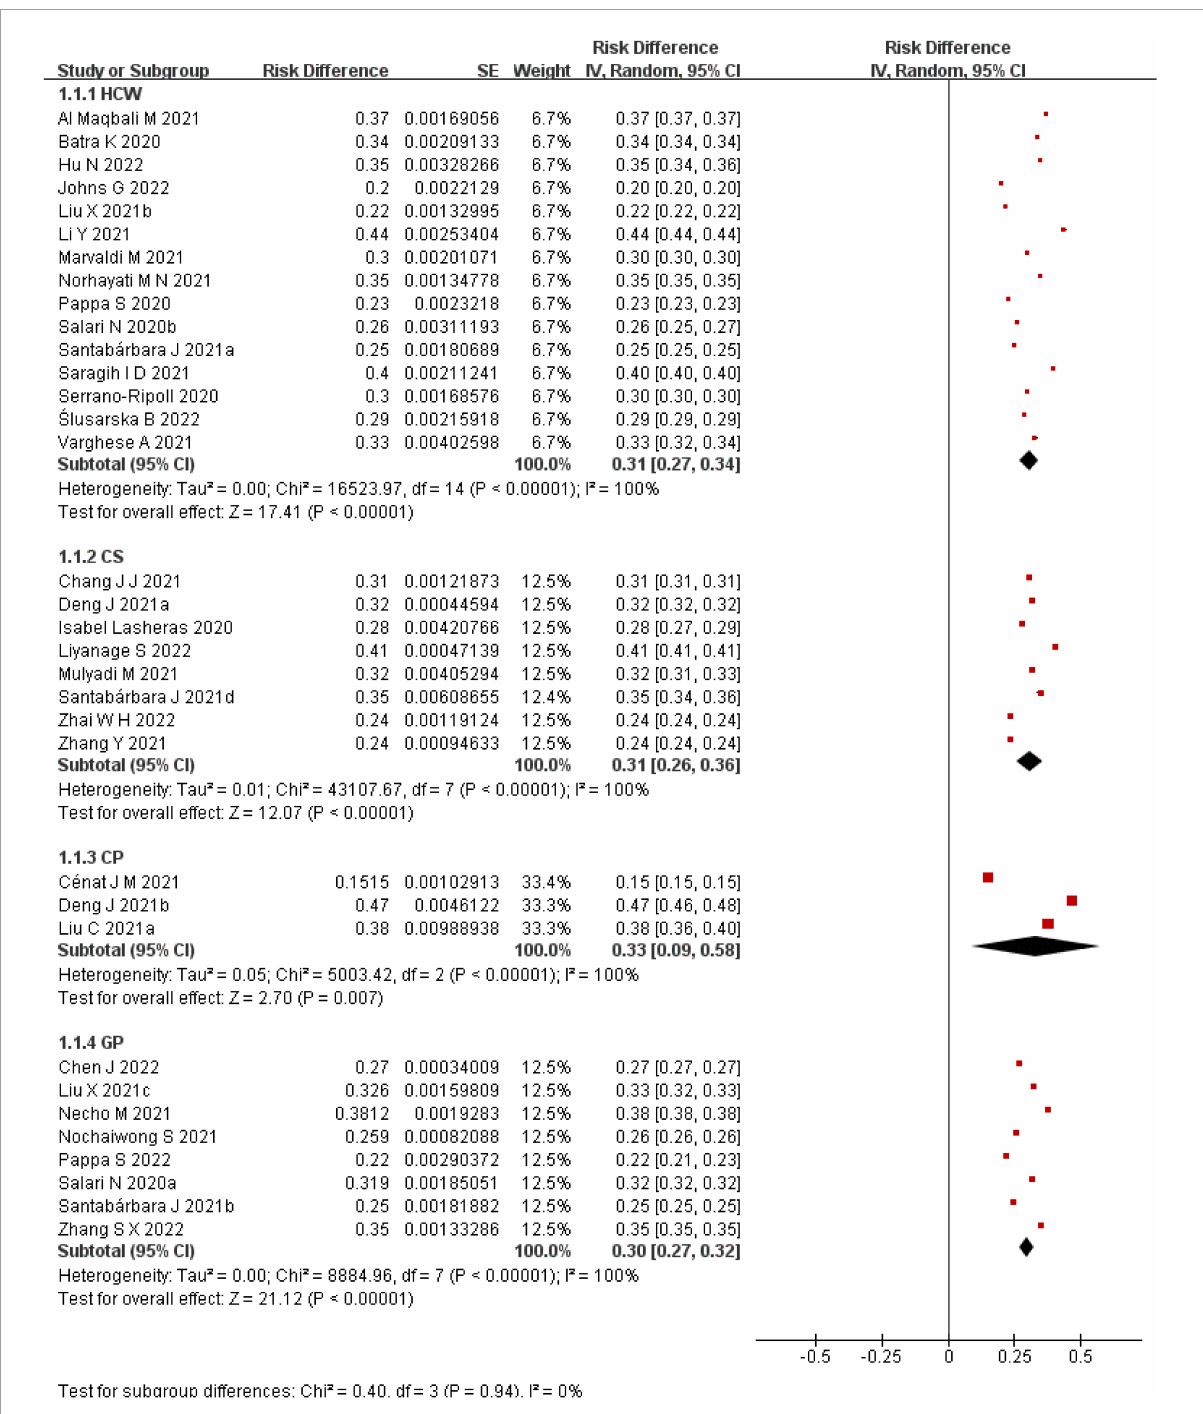
FIGURE4 A meta-analysis of the prevalence of anxiety.